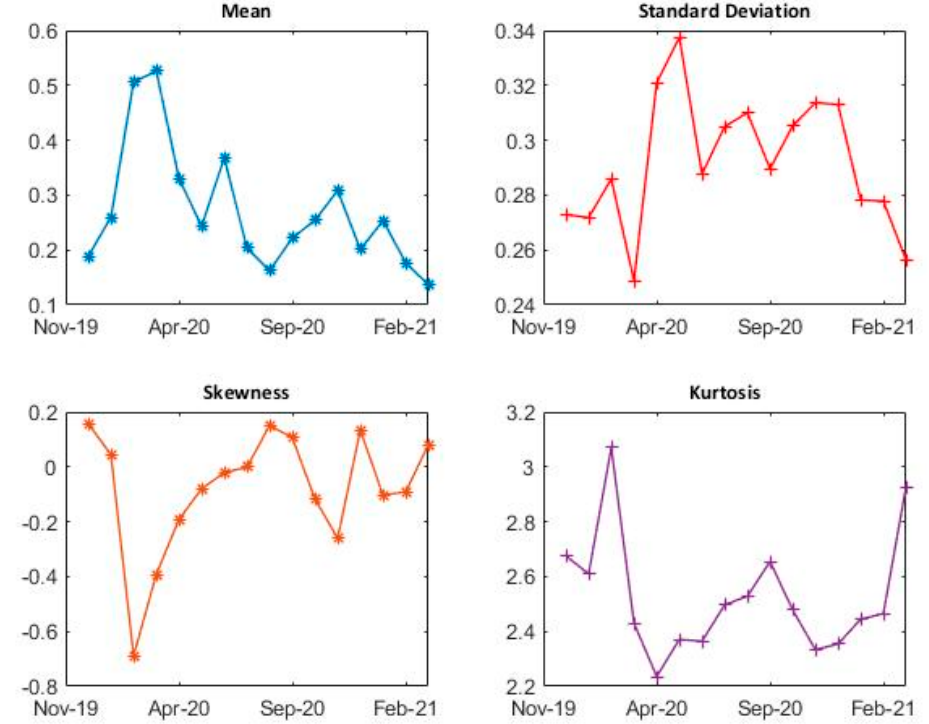
Figure 1. Time-varying basic statistics of the dynamic correlation matrices.